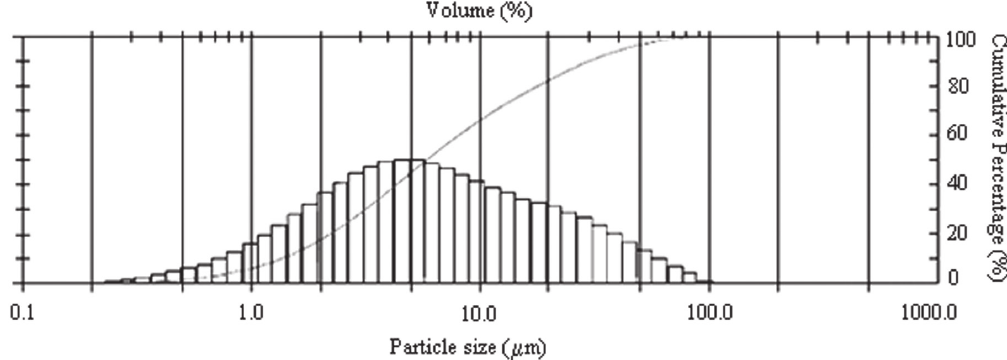
Fig. 1 - Percent distribution of the limestone powder particles.